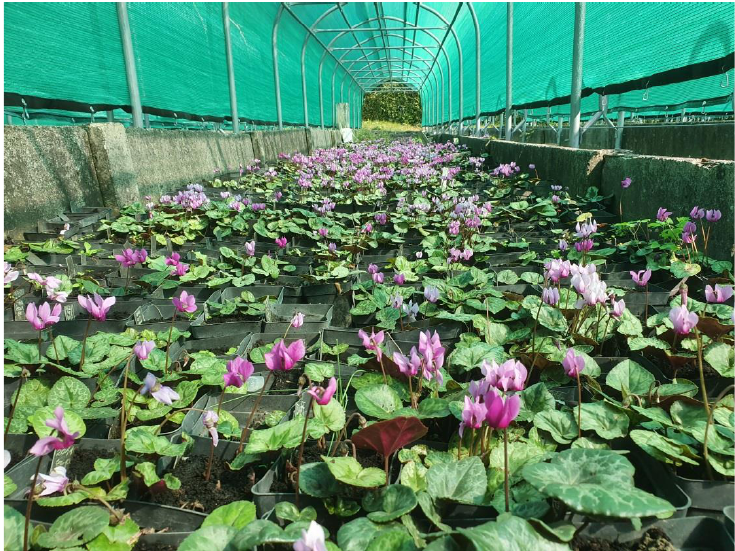
Figure 8. C. purpurascens plant collection in University Botanic Gardens Ljubljana (Ljubljana, Slo- venia).